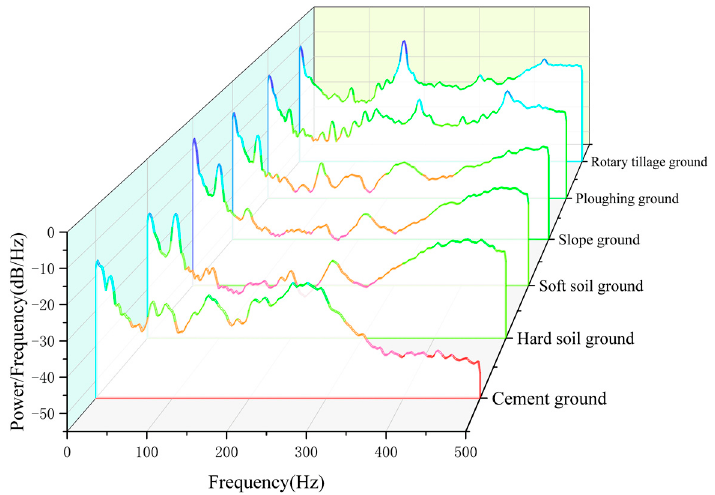
Figure 10. Welch power spectral density estimation of six ground vibration loads.